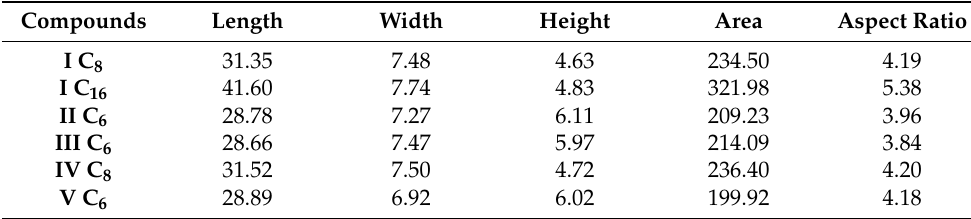
Table 3. The calculated dimensions (A), area (A 2 ), and aspect ratio of compounds I C 8 , I C 16 , II C 6 , III C 6 , IV C 8 , and V C 6